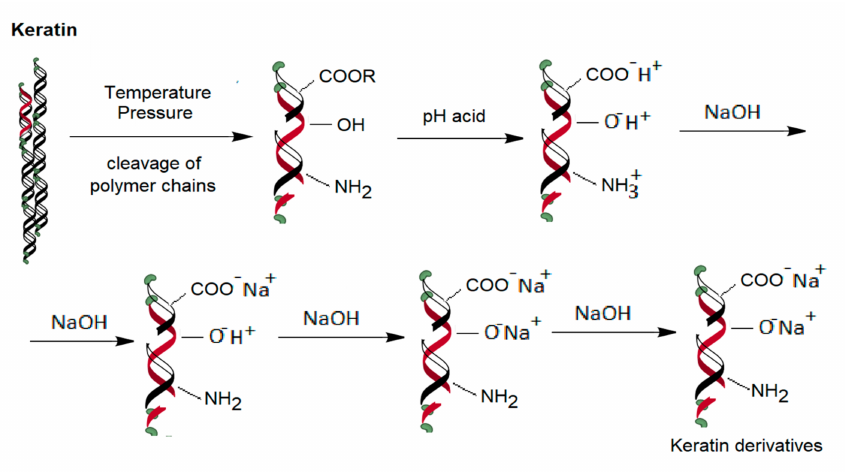
Figure 2. Schematic reaction to obtain the carboxylic derivatives, highlighted